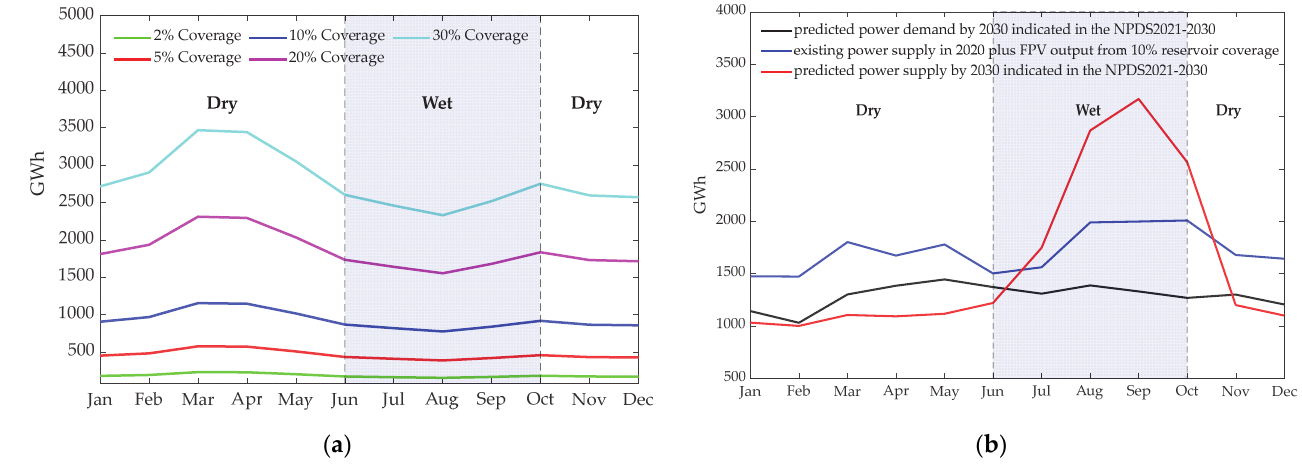
Figure 9. Results of estimated FPV potential. ( a ) Monthly sum FPV energy output for five cases of water surface coverage from four hydropower reservoirs; ( b ) comparison between the predicted power supply and demand by 2030 indicated in the NPDS 2021-2030 and the energy production of the proposed FPV output from 10% water surface coverage in four hydropower reservoirs.